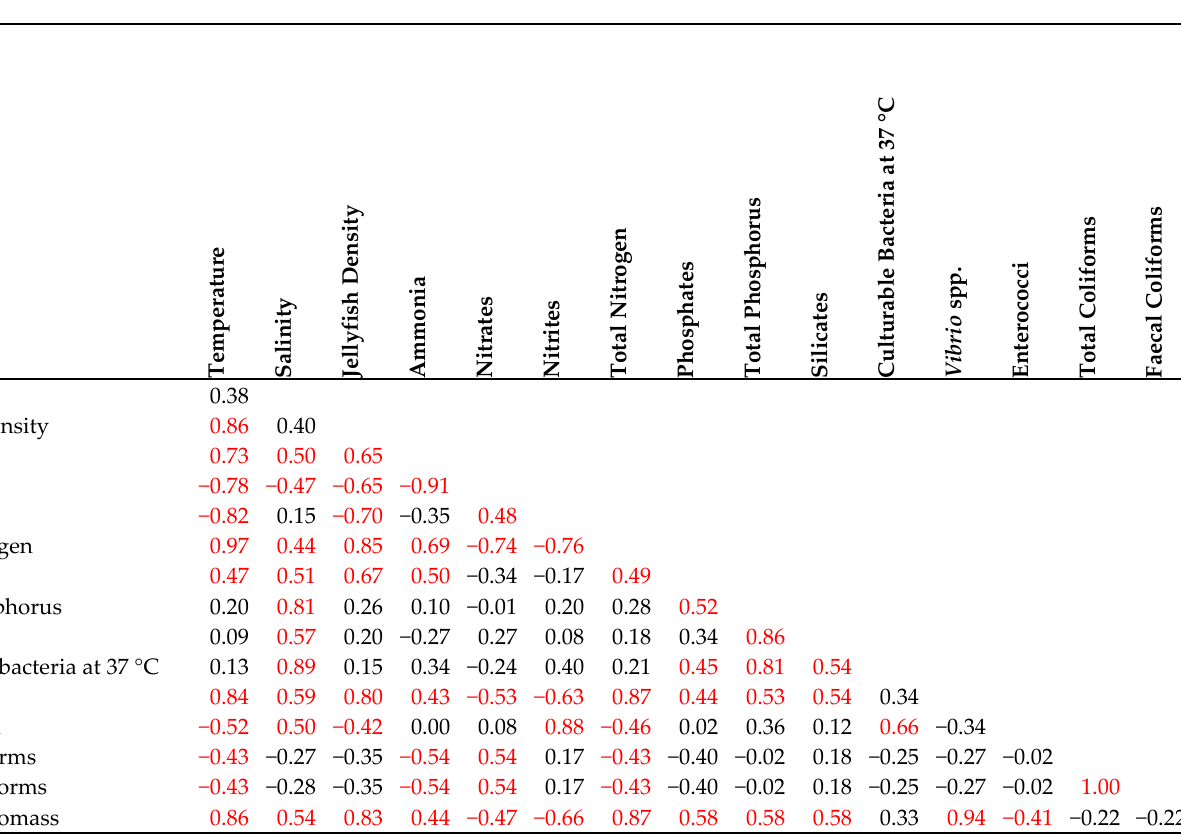
Table 3. Pearson’s correlation matrix for environmental, biochemical, and biological variables is presented. Number of samples = 24. In red, the correlations show statistical significance ( p < 0.05).